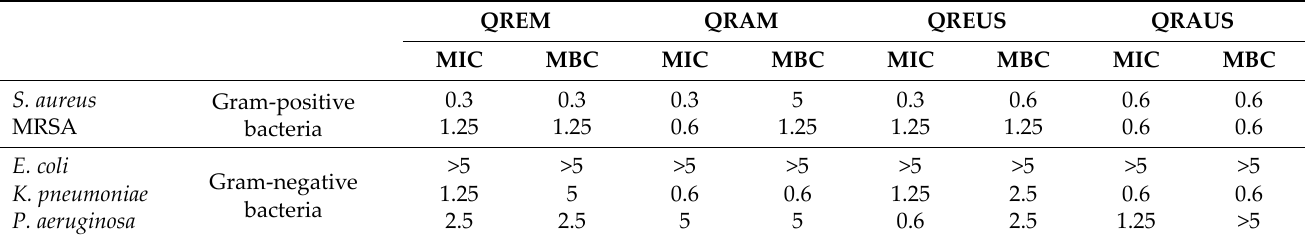
Table 3. The antimicrobial activity (mg/mL) of the Q. robur bark extracts.